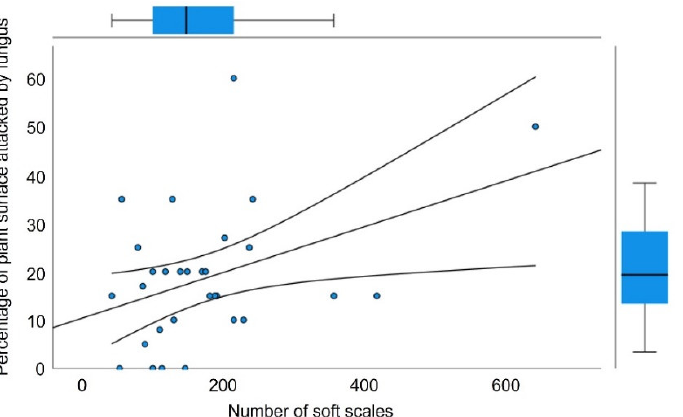
Figure 3. Relationship between the number of herbivores ( Toumeyella martinezae ) and percent area affected by fungi, showing an increasing trend. Boxplots along the axes’ margins show the dispersion of variable data; the trend line and corresponding 95% confidence bands are also shown.